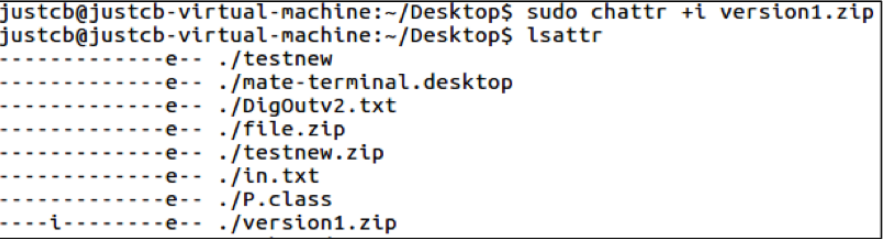
Figure 4. An example using chattr command to perform file write/delete protection.